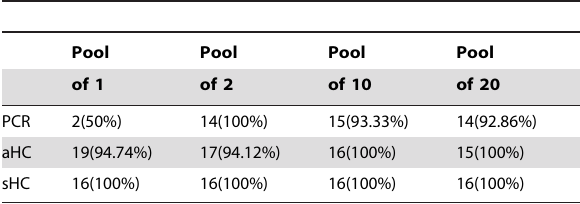
Table 4. 1KG support for HapMap false positive loci after duplicate